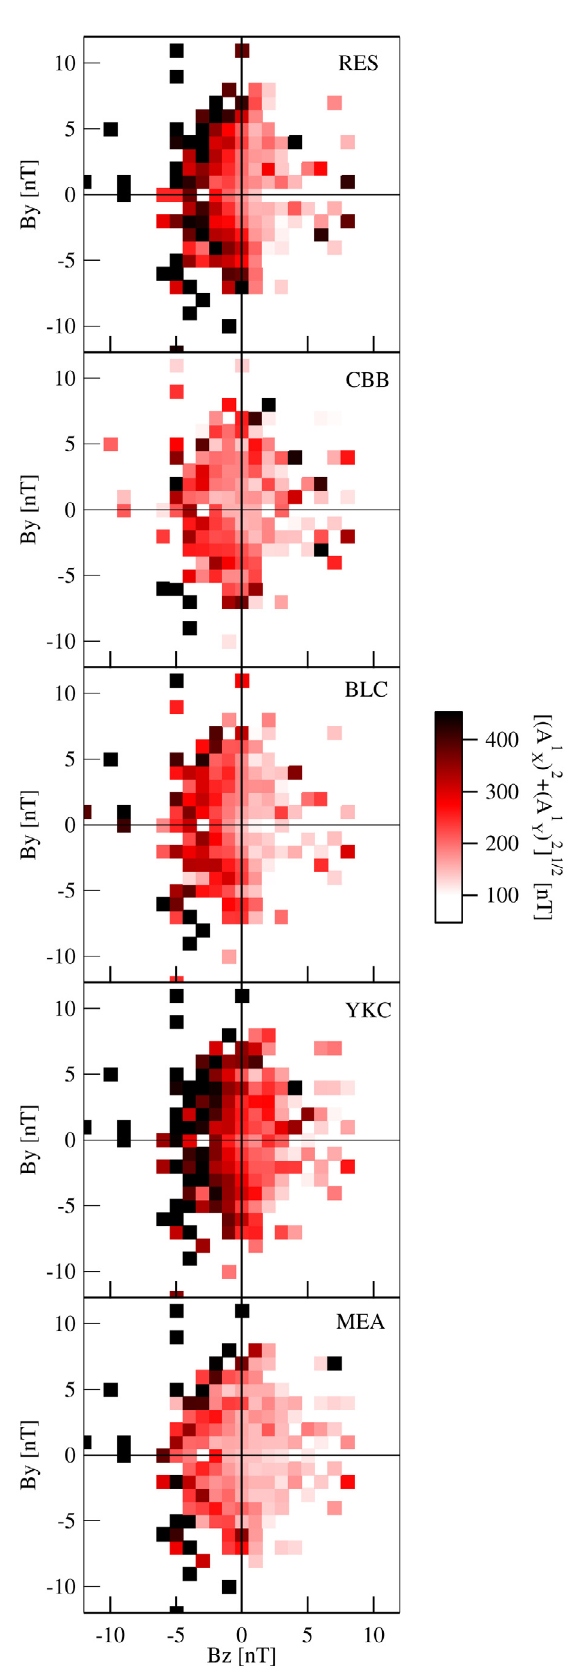
Figure 7. The amplitude module of the equivalent current vec- tors calculated by means of the second mode as a function of the y B and B values for each geomagnetic observatory considered in y z this study (note the change in